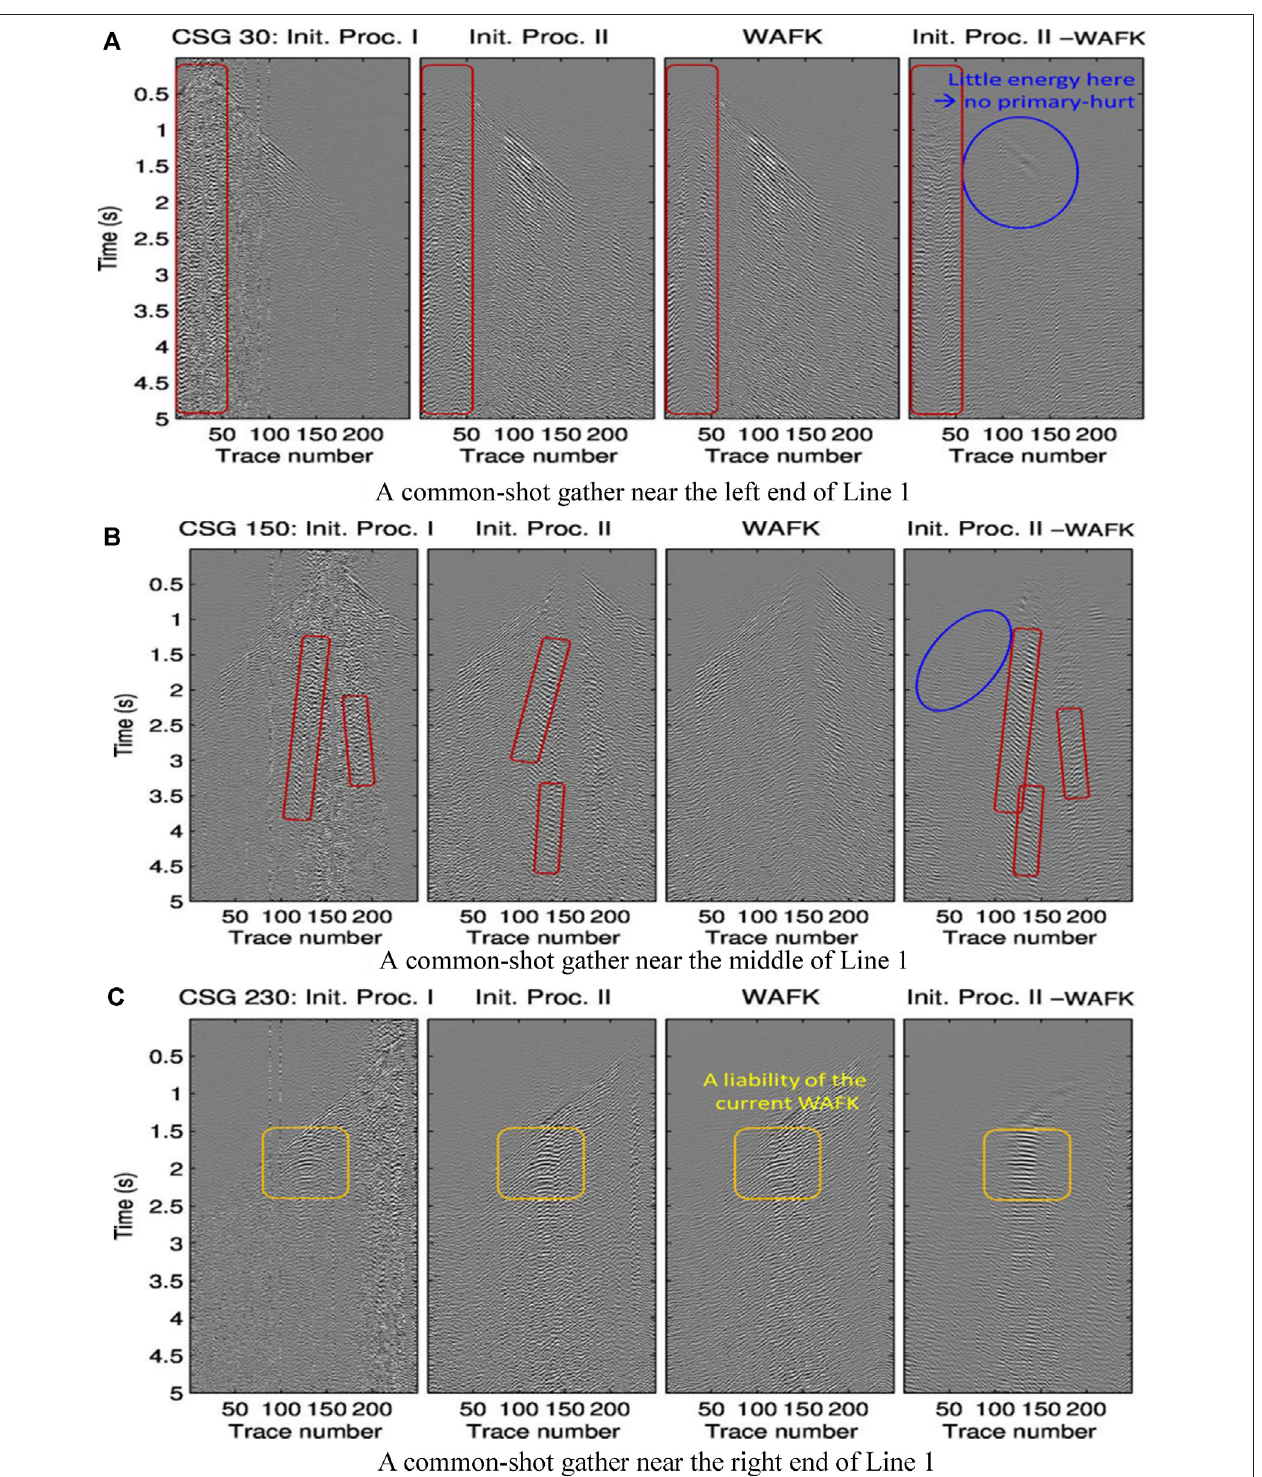
FIGURE 6 | Three common-shot gathers (CSGs 30, 150, and 230) corresponding to the three shots along Line 1: (A) CSG near the left end, (B) CSG around the middle, and (C) CSG near the right end of Line 1. The leftmost column shows an industry-processed data. The column titled “ Init. Proc. II ” presents the other industry- processed data. Our wavenumber-adaptive F-K fi lter (WAFK) operates upon this column, yielding results shown in column “ WAFK. ” The rightmost column shows the differencebetweentheinputsandoutputsofWAFK. (A) Acommon-shotgatherneartheleftendofLine1. (B) Acommon-shotgathernearthemiddleofLine1. (C) A common-shot gather near the right end of Line 1.